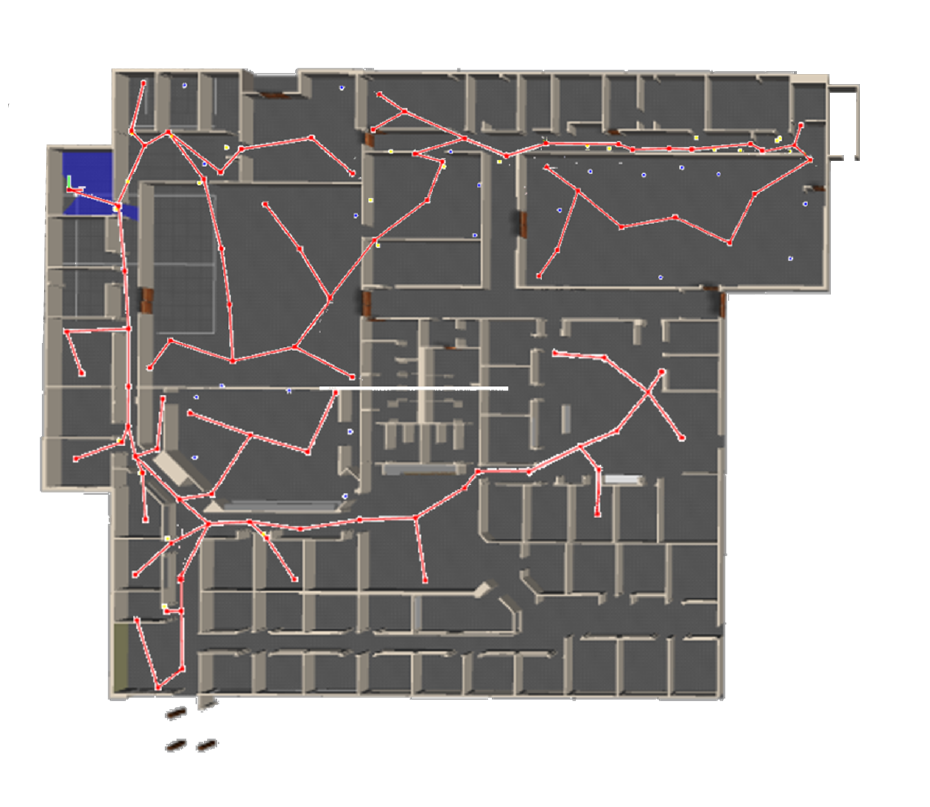
Figure 1. Result of autonomous exploration and mapping of the Willow Garage office environment using the proposed method. The resulting graph for the mapped area is overlapped over the Gazebo